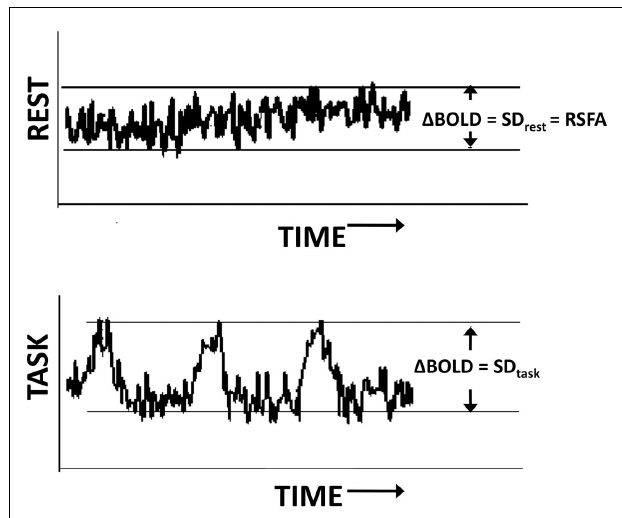
FIGURE 1 | Estimation of the BOLD amplitude change during the resting state (top) and task (bottom) using the temporal SD of the time